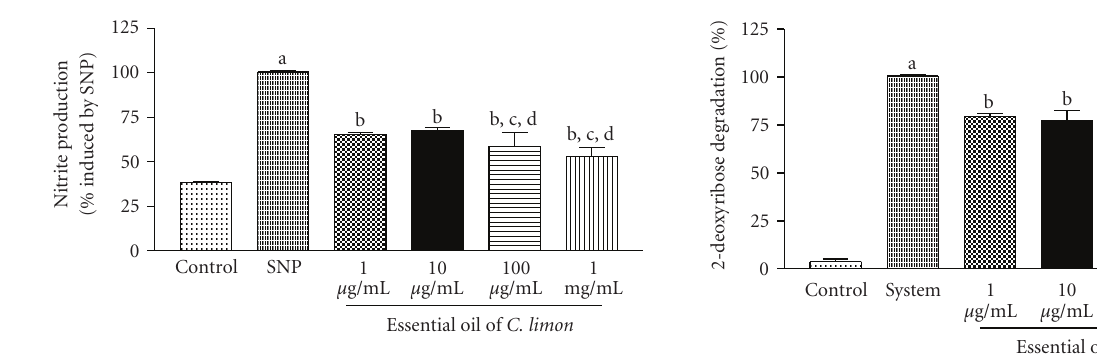
Table 1: E ff ects of essential oil (EO) of C. limon , morphine (MOR), and naloxone (NAL) on writhing induced by acetic acid.